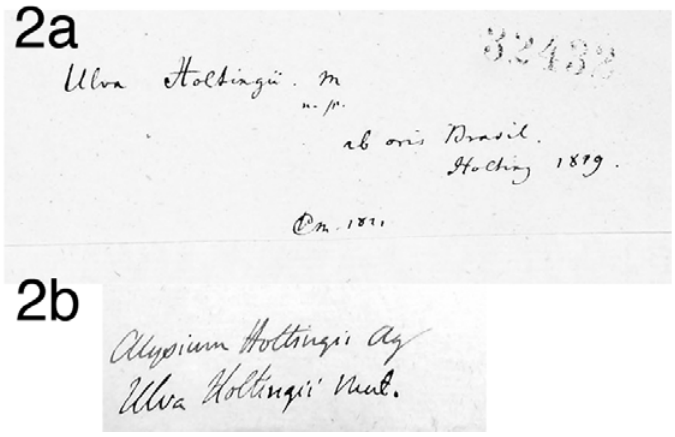
Fig. 2 – Label data: a , words near specimen; b , words at bottom corner of sheet.